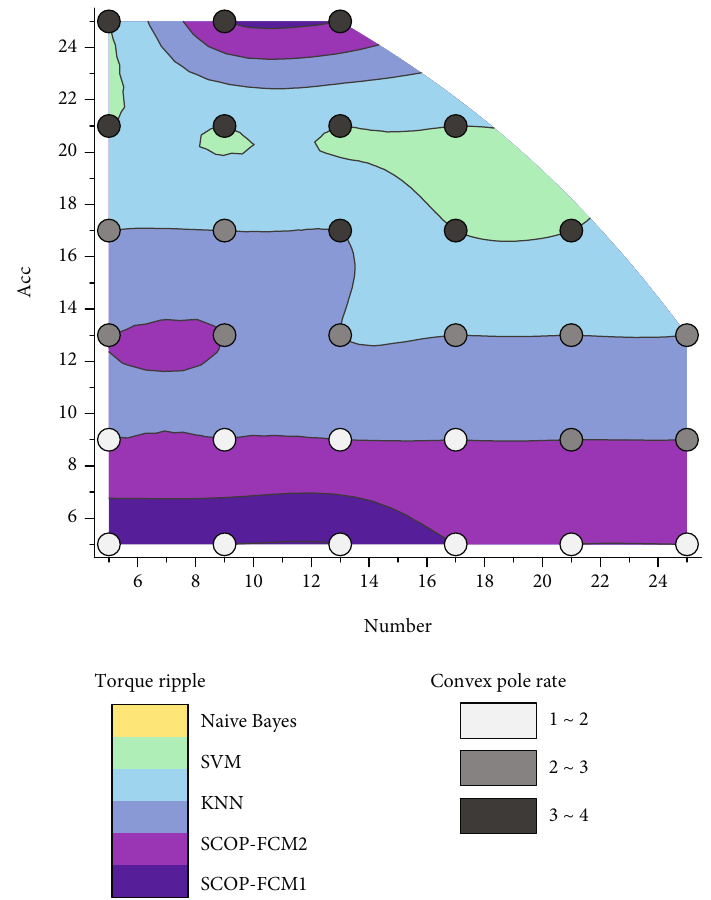
Figure 8: Evaluation of DEM elevation